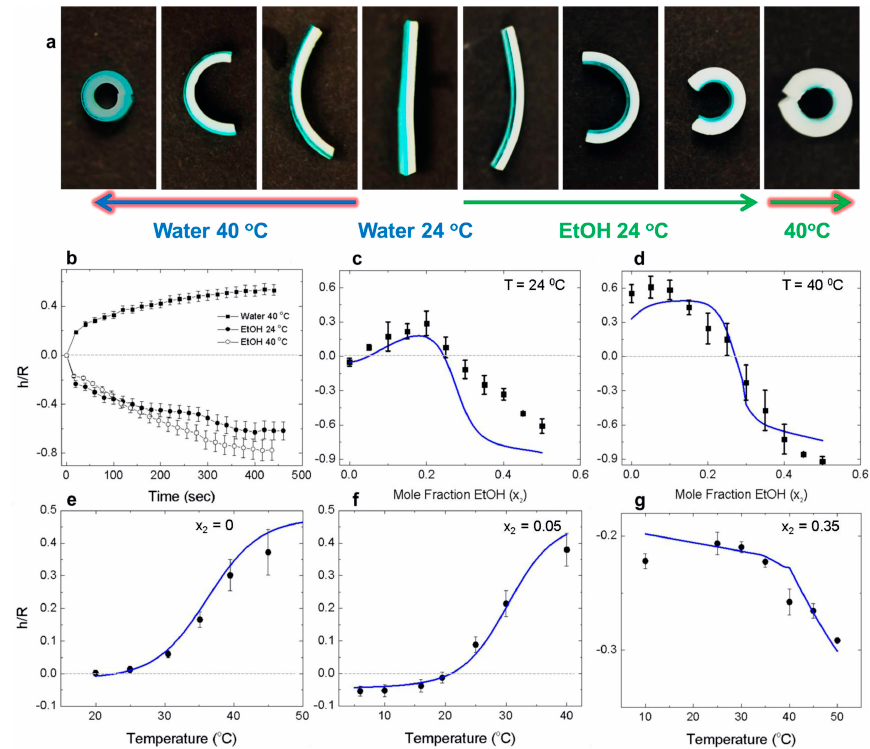
Figure 3. Bending behavior of bilayer gel actuators at various temperatures and EtOH concentrations. ( a ) Photographs of a bilayer gel actuator showing positive curvature in pure water at 40 °C and negative curvature after immersion in EtOH at 24 °C ( x 2 = 0.5). The last frame shows the amplification of the bending magnitude as the temperature is increased to 40 °C to induce the UCST behavior of pNIPAAm. The pNaAc layer has been stained with brilliant green dye for visualization. Scale bar = 2 mm. ( b ) The normalized bending curvature as a function of time in pure water and EtOH ( x 2 = 0.5). ( c ) Bilayer bending behavior at 24 °C as a function of x 2 . ( d ) Bilayer bending behavior at 40 °C as a function of x 2 . ( e ) Bilayer bending behavior in pure water as function of T . ( f ) Bilayer bending behavior at x 2 = 0.05 as function of T . ( g ) Bilayer bending behavior at x 2 = 0.35 as function of T . The solid blue lines are the fit curves from Equation (1). The dashed lines provide a guide for the transition from positive to negative curvature.